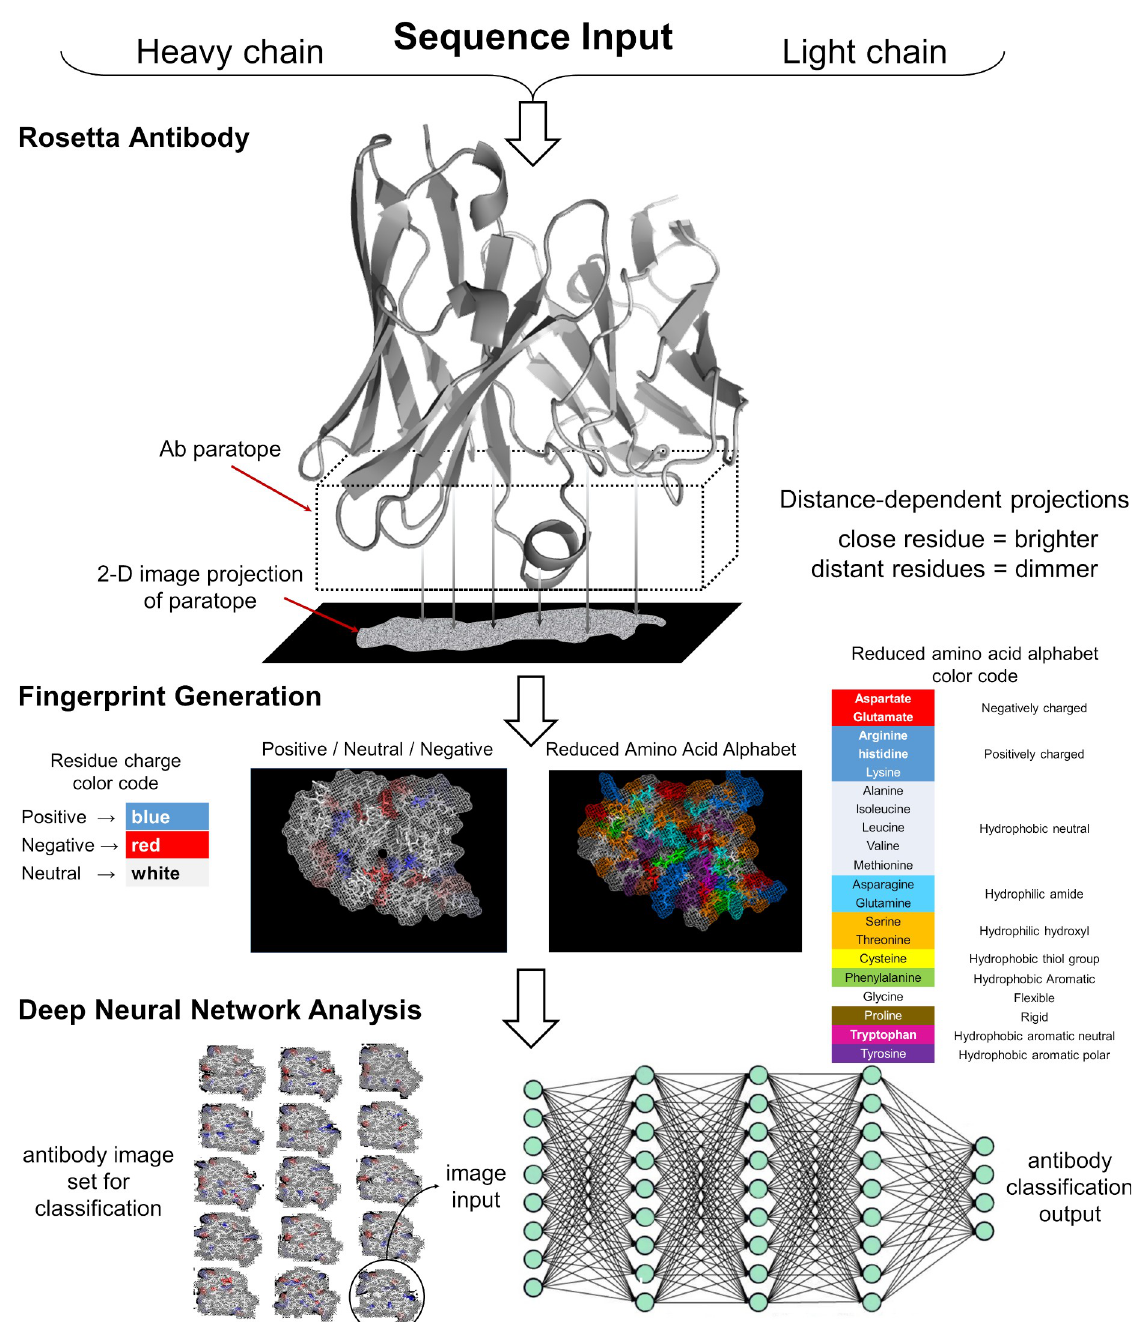
Fig 1. Schematic overview describing the steps required to generate fingerprints for Deep Neural Network image analysis. We used the Rosetta Antibody software to generate multiple 3-D models of a particular Ab or one of its antibody binding fragment (FAB) using the light and heavy chain sequences as input data. For each 3-D model, we used PYMOL to produce a fine grid perpendicular to the main axis of the Ab, which intersects the Ab binding site region. We selected amino acid residues from the model that lies within a distance of 20 Å from the grid, and their atoms were projected onto the 2-D grid and displayed using a “dot” representation. The image was then colored according to the desired color-scheme using either a charge or an amino acid property based representation. The resulting image was then stored as an image file. The transformation of the sequence into an image allowed us to train DNNs models for Ab classification purposes using collections of fingerprint sets from multiple Abs.